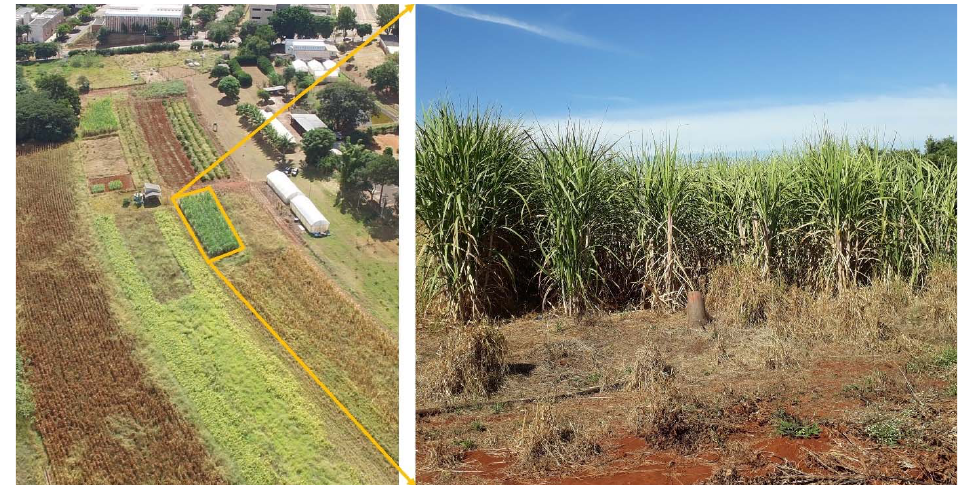
Figure 1. General view of the experimental area with a sugarcane crop. Table 2. Dates of surveys carried out in the experimental area. Survey Dates Days after Planting